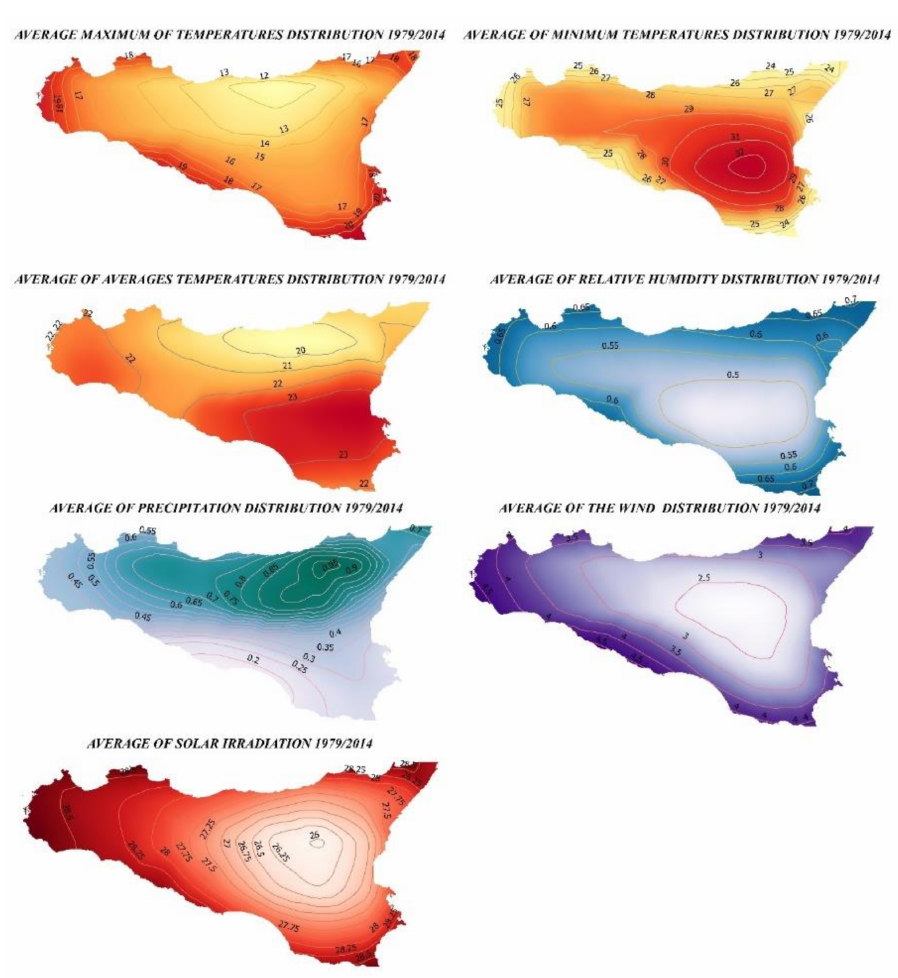
Figure A2. Spatial Distribution of the Climatic Variables of